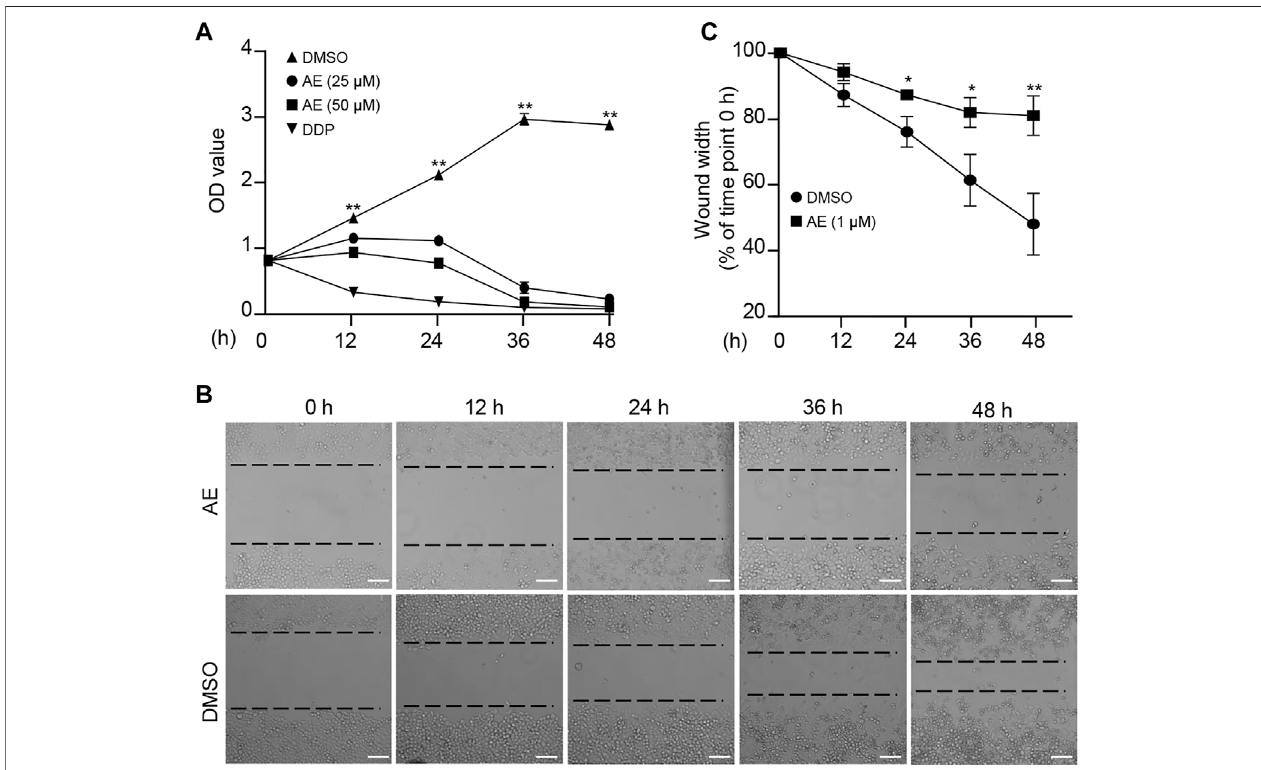
FIGURE1| AEinhibitstheproliferationandmigrationofHeLacells. (A) EffectsofAEontheproliferationofHeLacells.HeLacellsweretreatedwithAEorDDPforthe indicated hours, and the cell proliferation was examined by the CCK-8 assay. (B,C) Effects of AE on the migration of HeLa cells. Cell migration was detected by wound scratch assay. The wound width was calculated using ImageJ. Results are as means ± SD from three independent experiments. * p < 0.05, ** p < 0.01. Scale bar, 100 μ m.